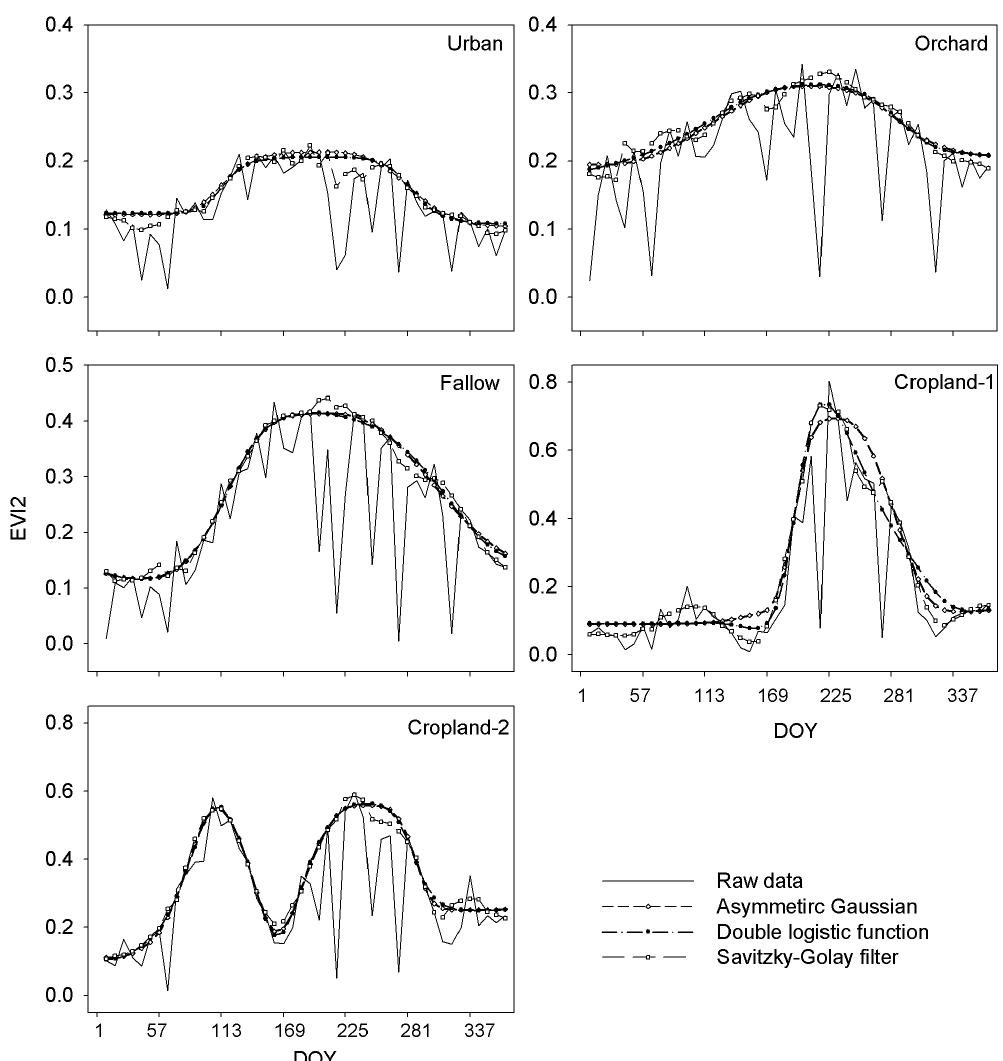
Figure 2. Time series EVI2 data of land cover types processed before and after noise reduction methods. doi:10.1371/journal.pone.0070079.g002 PLOS ONE |